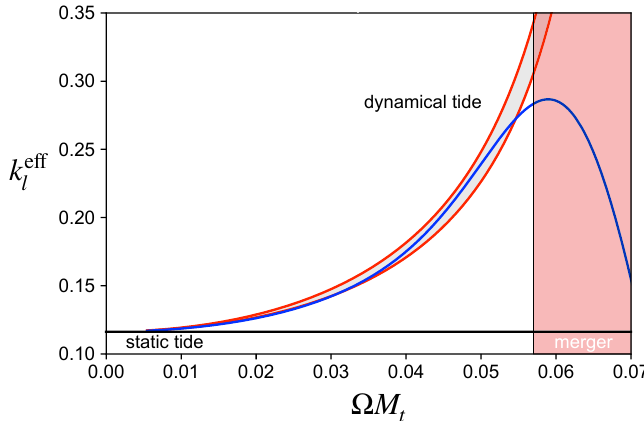
Figure 1. Comparing the effective Love number k eff from (58), using δ = 1 − 2 C , to the results l from [79] for the quadrupole ( l = 2) contribution to the dynamical tide. The horizontal line represents the static Love number ( k l = k eff in the Ω → 0 limit). The result from [79] is shown as a solid blue l curve, while estimates from (58) are shown for the range (cid:101) = 0.85 − 0.9 with the latter representing the lower edge of the filled (grey) band. The region beyond the merger frequency, Ω M t ≈ 0.057, with M t the total mass of the binary, is indicated by the shaded